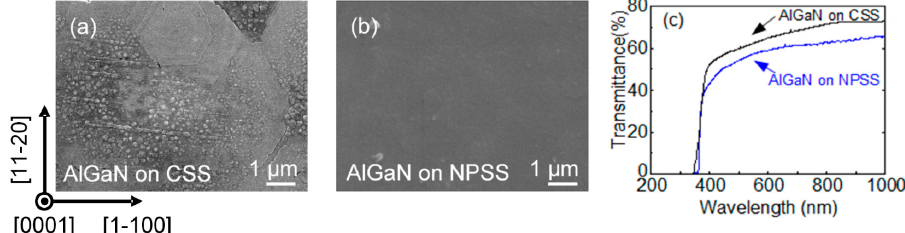
Figure 2. Schematic illustrations of the ( a ) top- and ( b ) side-view dimensions of the nanoscale- patterned sapphire substrate (NPSS) design used in this study. ( c ) SEM surface morphology of the as-etched NPSS. Figure 3. SEM surface morphologies of the AlGaN epilayers grown on the ( a ) conventional sapphire substrate (CSS) and ( b ) NPSS. The corresponding transmittance spectra are shown in ( c ).